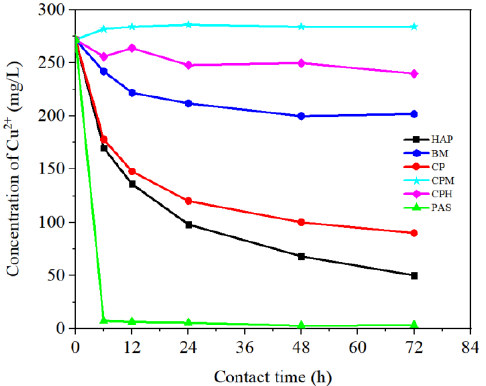
Figure 1. The concentration variation of Cu 2+ in six phosphate treatments within 0 to 72 h.